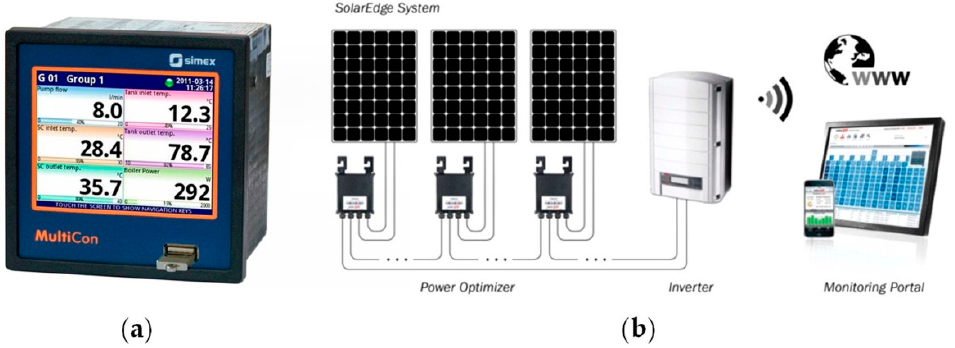
Figure 4. ( a ) Multicon Simex CMC141 data logger; ( b ) SolarEdge System.